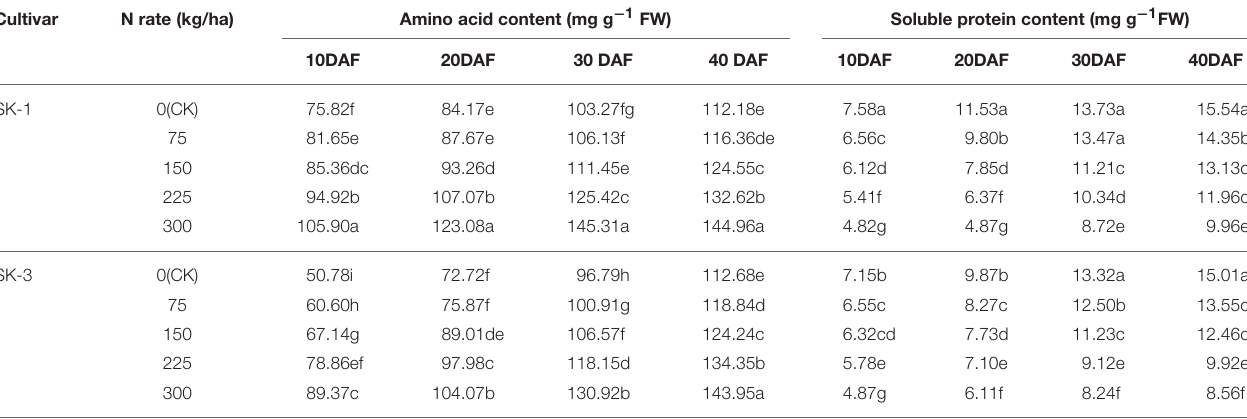
TABLE 5 | The effect of the nitrogen level on the boll shell amino acid and soluble protein content of the two Bt cotton cultivars in 2015. Cultivar